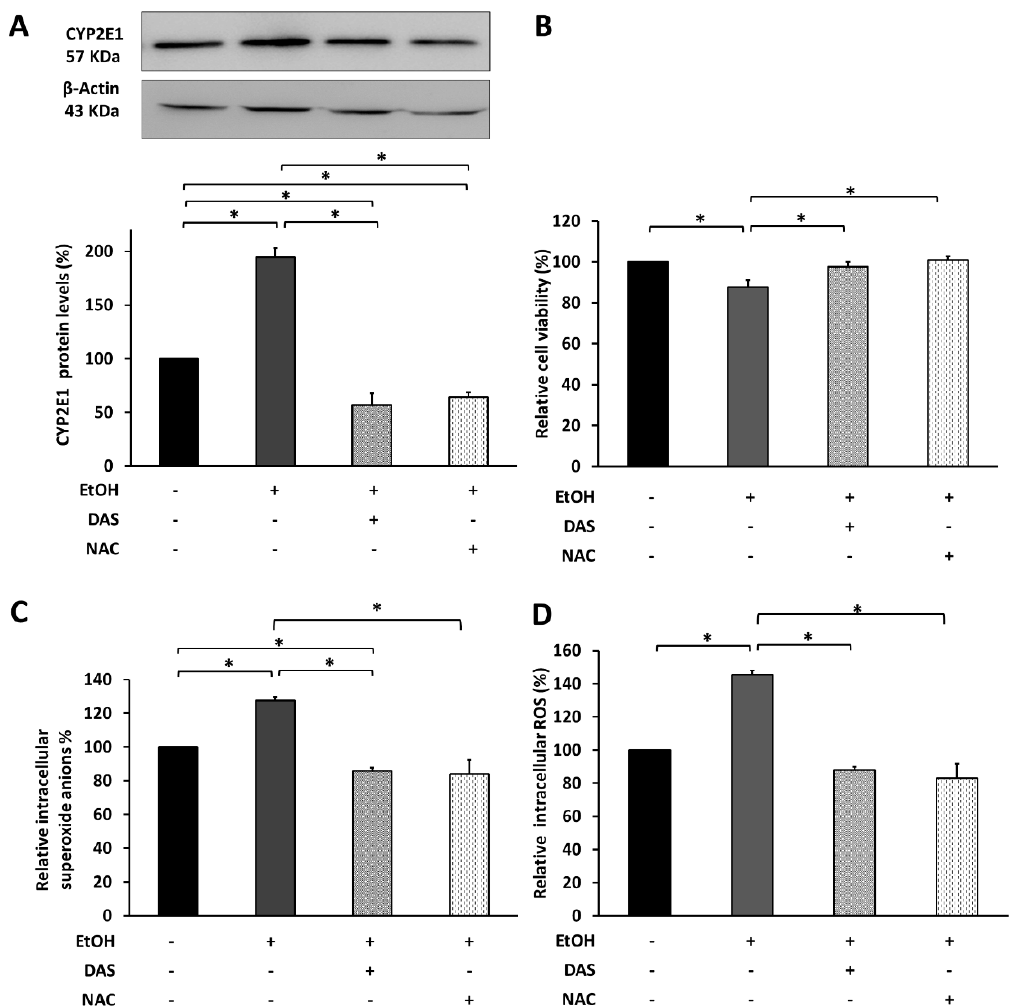
Figure 5. EtOH-induced oxidative stress promotes CYP2E1 upregulation and cell death. ( A ) CYP2E1 protein levels in ARPE-19 after 600 mM EtOH treatment and 20 mM DAS or 4 μM NAC measured by WB. ( B ) Cell viability by XTT assay. ( C ) Superoxide anions by DHE fluorescence and ( D ) Total intracellular ROS by DCFH fluorescence. Protein levels were normalized by β-Actin. Values are expressed as mean ± SEM (N = 3). Statistically significant differences were set at * p < 0.05.